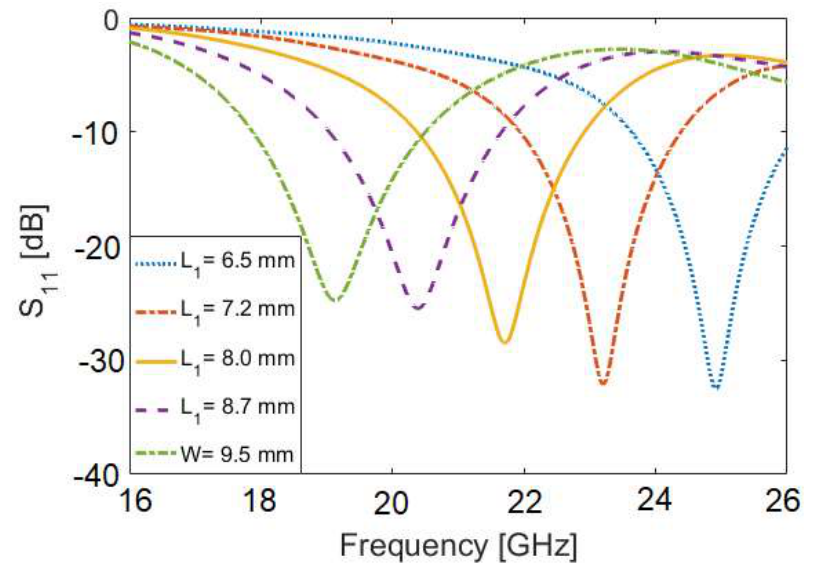
Figure 5. Operation-frequency tuning of the designed antenna for different lengths of the slot resonator.